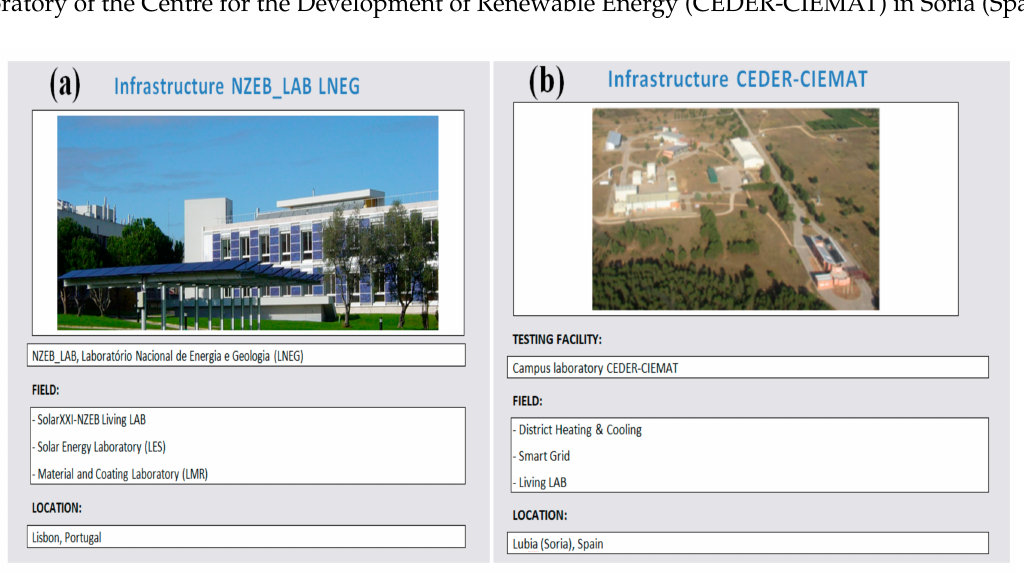
Figure 1. Examples of factsheet developed by module 2 of the European Energy Research Alliance Joint Programme on Smart Cities (EERA JP SC). ( a ) NZEB lab in the facilities of LNEG, ( b ) campus lab in the facilities of